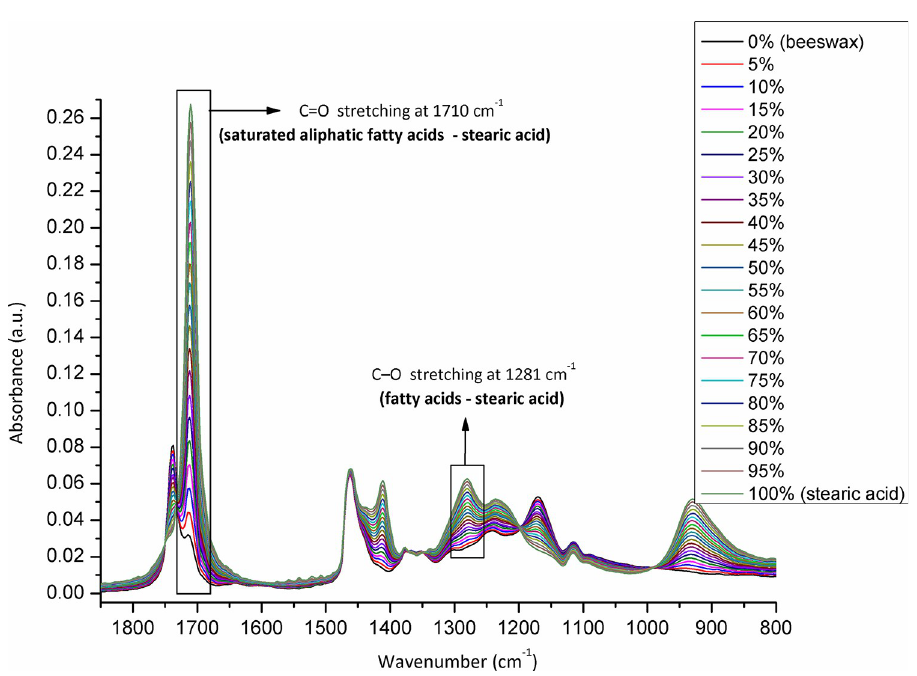
Fig 4. FTIR-ATR spectra of reference standards (stearic acid-beeswax mixtures containing different proportions of stearic acid) used for calibration. Wavenumber, the number of waves per unit distance; cm, centimetre; a.u. is for the absorbance